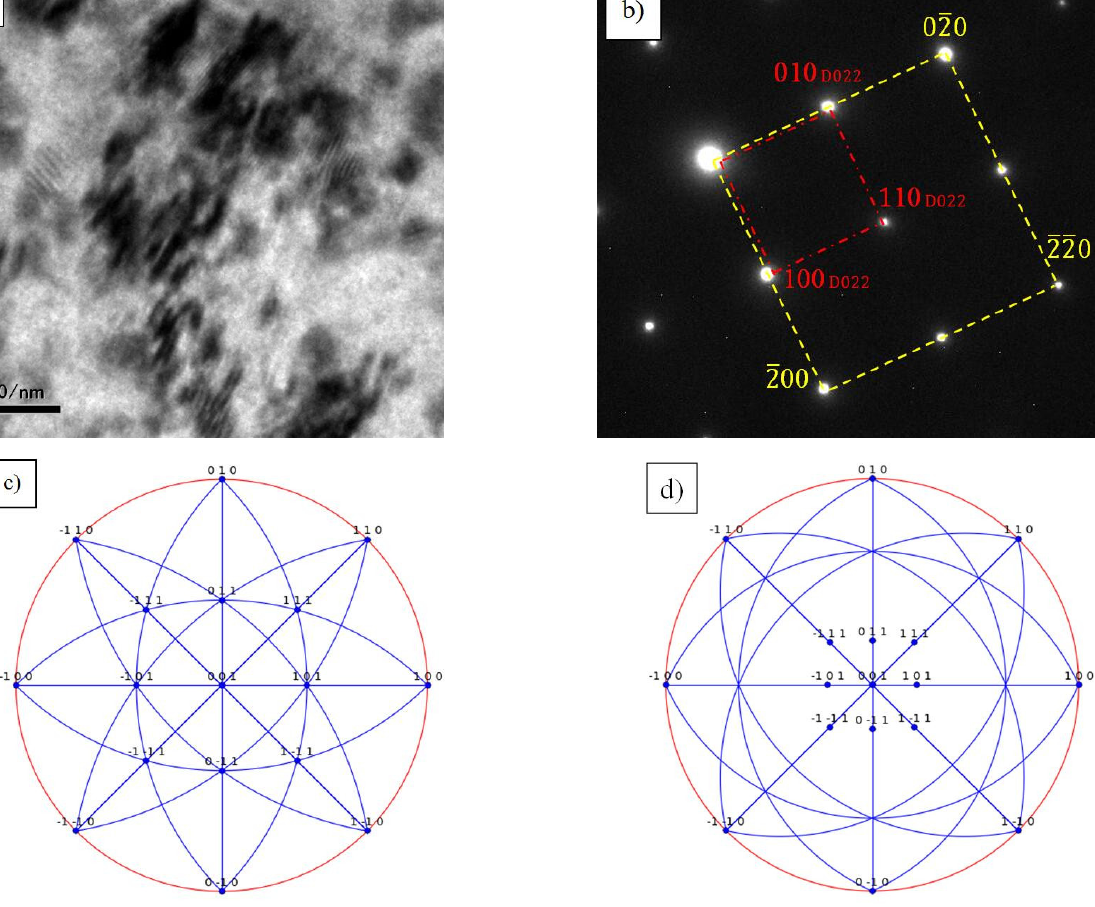
Figure 13. The TEM structure of D0 22 -Al 3 Ta phase. ( a ) the morphology of D0 22 -Al 3 Ta phase; ( b ) the diffraction pattern of D0 22 -Al 3 Ta phase; ( c ) the stereographic projection of the matrix; ( d ) the stereographic projection of D0 22 -Al 3 Ta phase.